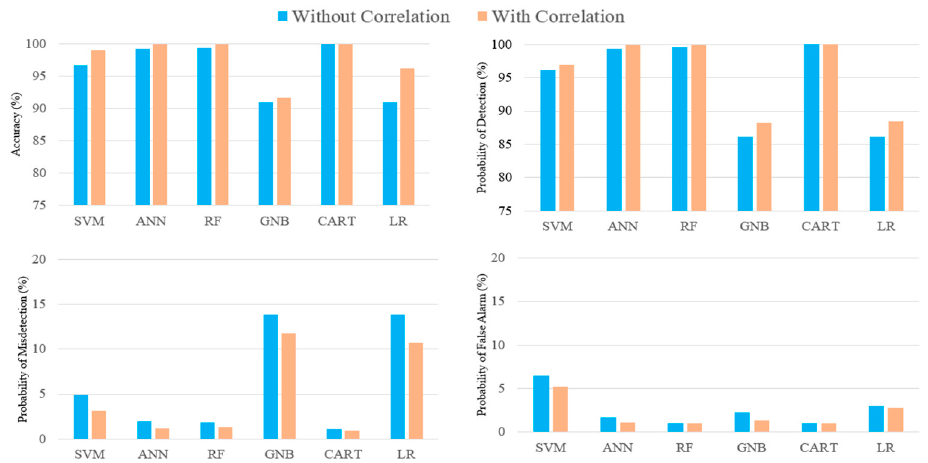
Figure 5. Results of feature correlation and feature importance. ( a ) Heatmap of Pearson’s Correlation Coefficient technique; ( b ) Chi-Square Feature Importance.